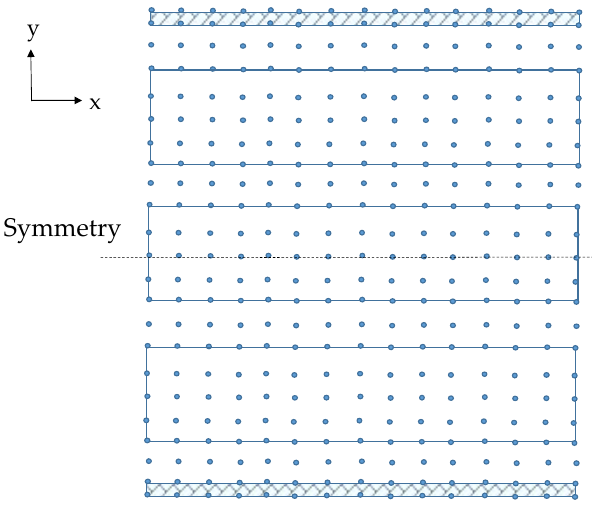
Figure 3. Schematic diagram of the nodal grid of the LHST.